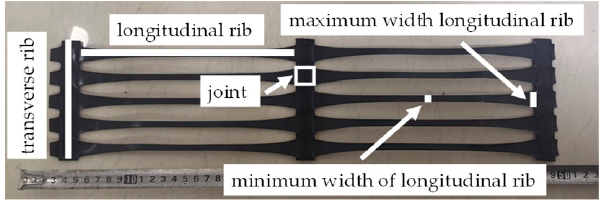
Figure 4. Uniaxial HDPE geogrid.